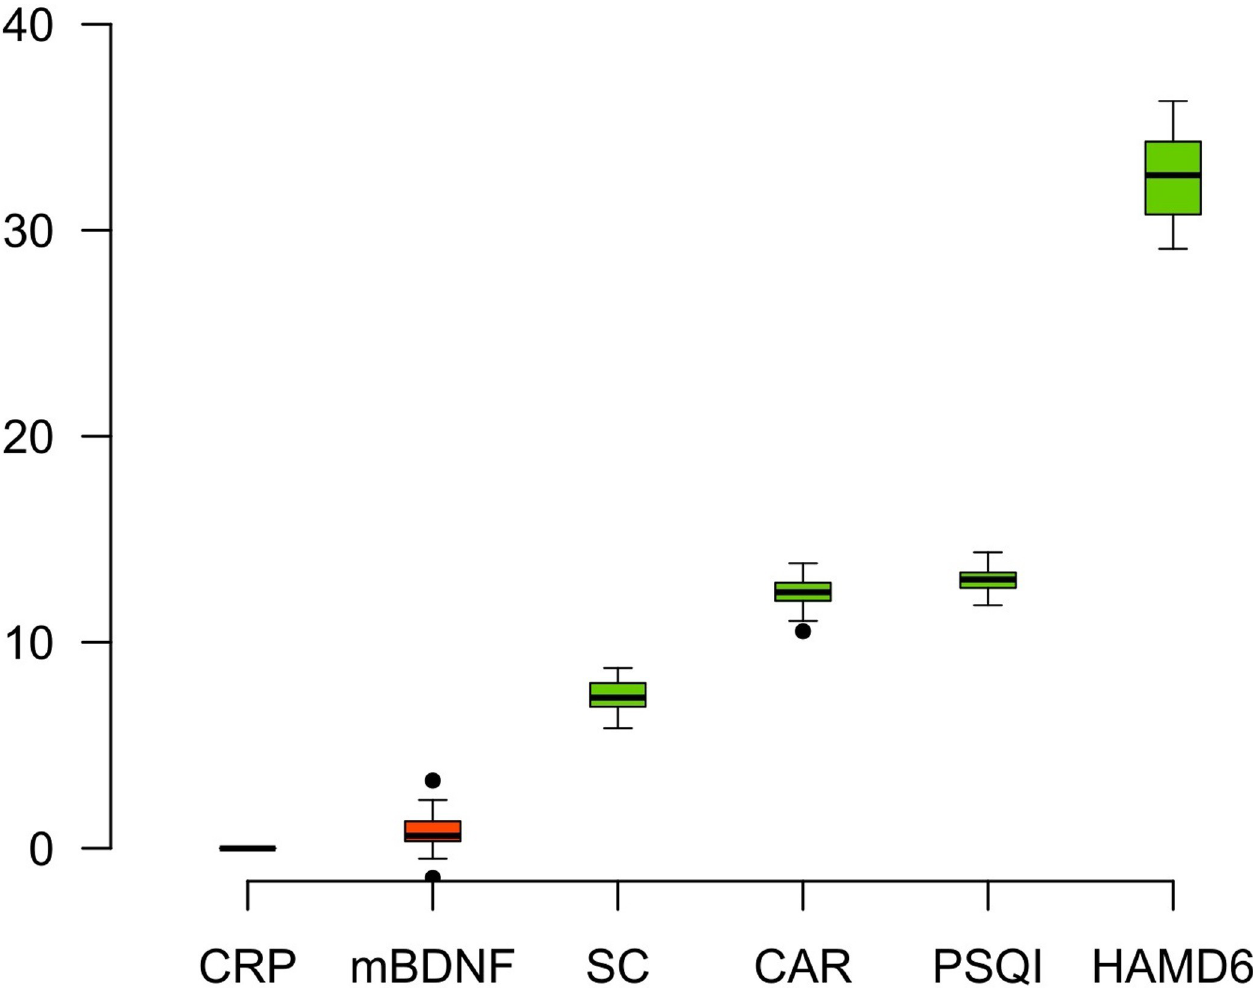
Fig 1. The random forest-based algorithm (Boruta) of parameter relevance for discrimination between patients in first depressive episode (MD n = 30) and control group (CG n = 32). Colors: green = relevant (p < 0.05); yellow = tentative of relevance; red = no relevant.